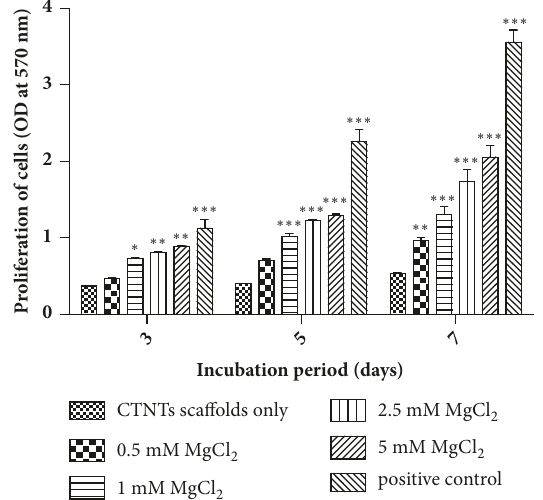
Figure 7: Proliferation effect of MG63 cells grown on CTNTs scaffolds only, CTNTs scaffolds functionalized with different con- centrations of MgCl 2 and polystyrene well (positive control) as evaluated by MTT assay on the culture periods of 3, 5, and 7 days ( ∗ p < 0.05, ∗∗ p < 0.01, ∗ ∗ ∗ p < 0.001, n =